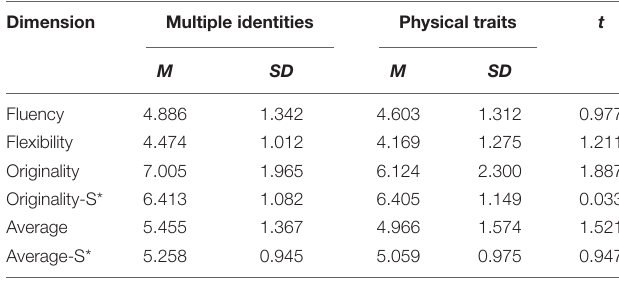
TABLE 2 | Divergent thinking test scores for the multiple identities and physical trait conditions ( N = 76).